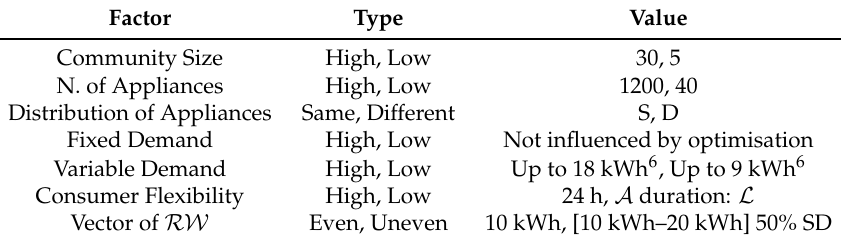
Table 3. List of factors for the different case scenarios.